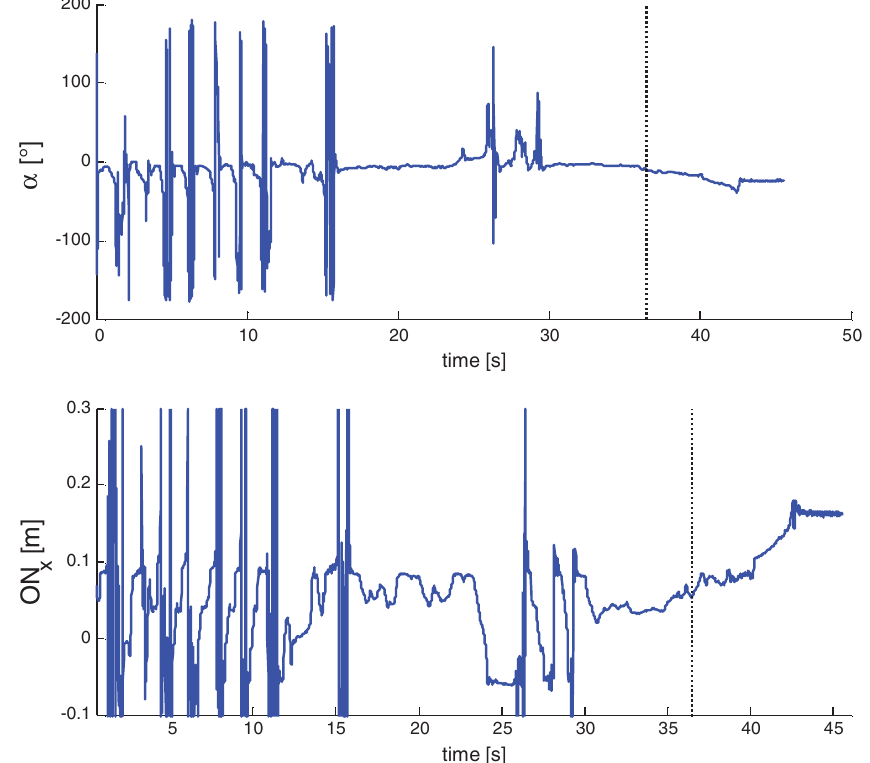
Fig. 8. Ground/foot force angle and centre of pressure position (vertical lines indicate the instant of knee unlocking).